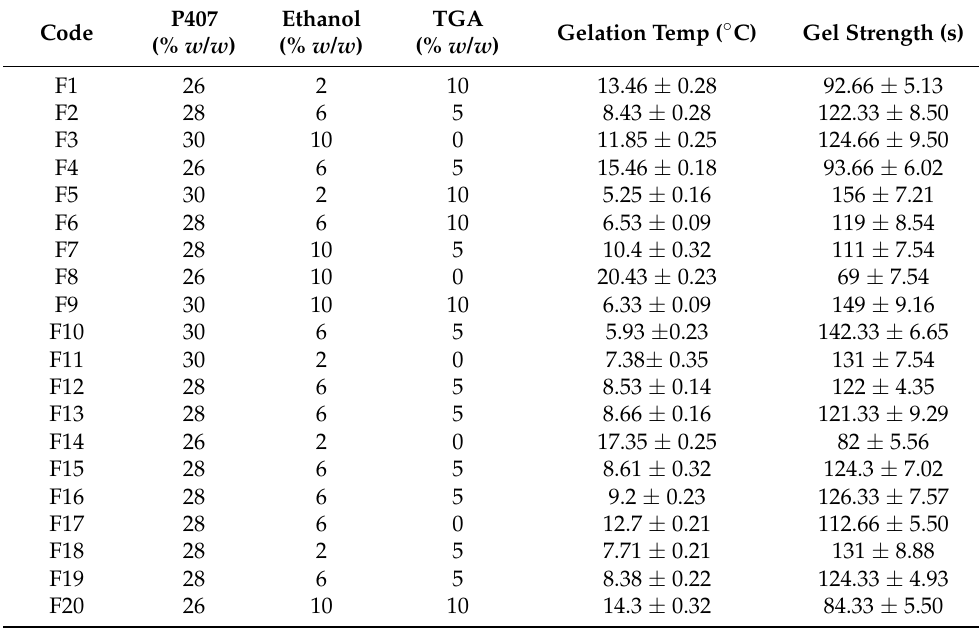
Table 2. Different runs of face-centered central composite design and corresponding